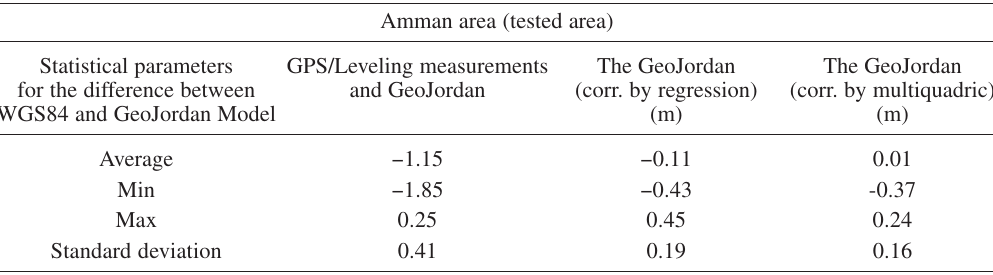
Table II. Statistical parameters for the differences between WGS84 and GeoJordan Model (corrected by a re- gression plane and multiquadric). Amman area (tested